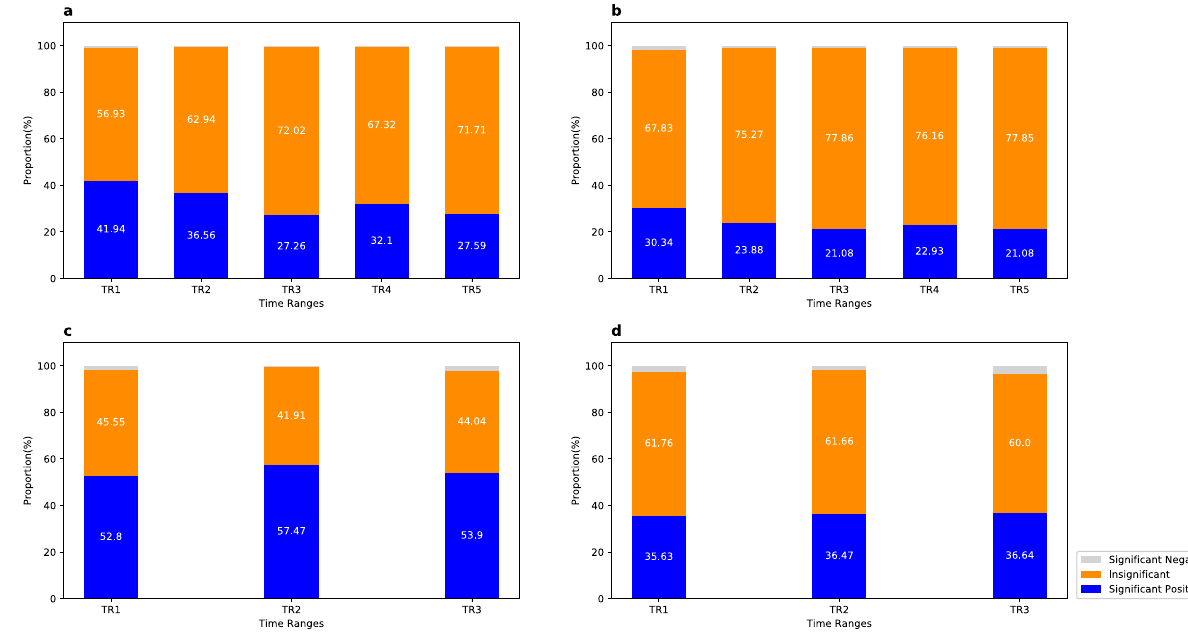
Figure 5. Proportions of Spatial–temporal (ST) correlations and spatial–temporal partial (STP) correlations of travel speeds. We provide the average results of different time periods here because different time periods have little effect on ST and STP correlation (see Supplemental Tables S6 and S7). The three colors in each bar represent the average proportions from different time periods within a specific time range, for significant positive, insignificant, and significant negative spatial or SP correlations, respectively. ( a ) Urban road network (ST). ( b ) Urban road network (STP). ( c ) Freeway network (ST). ( d ) Freeway network